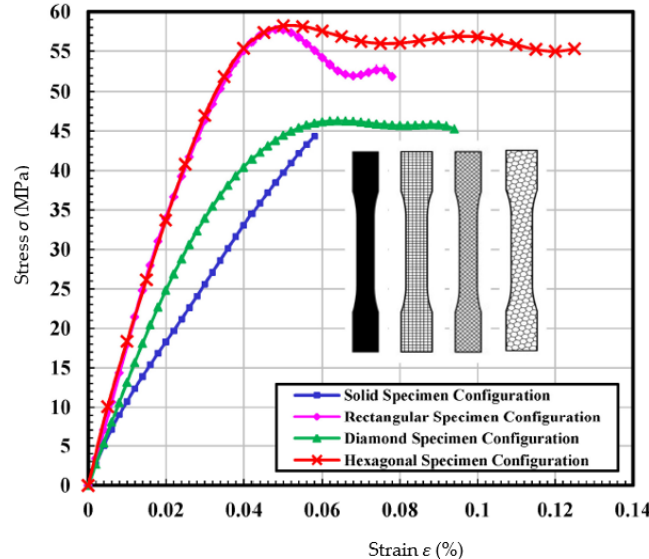
Figure 22. Average engineering stress–strain curves for solid, rectangular, diamond, and hexagonal infill test specimen configurations [157].